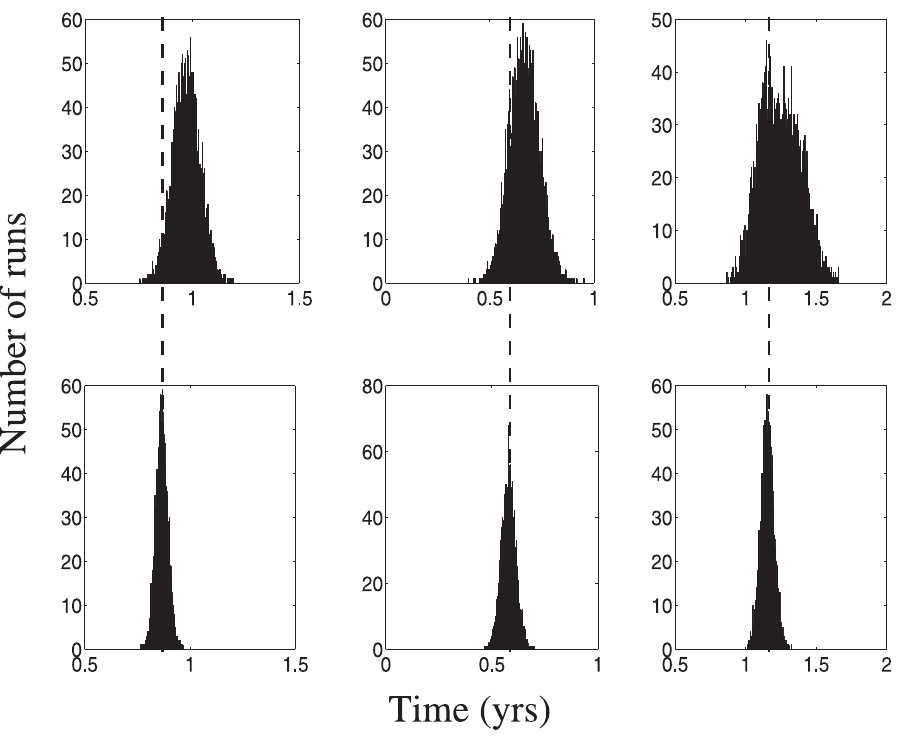
Figure 6. Counting method: the standard deviation of stage durations. All the parameters are as in figure 4.